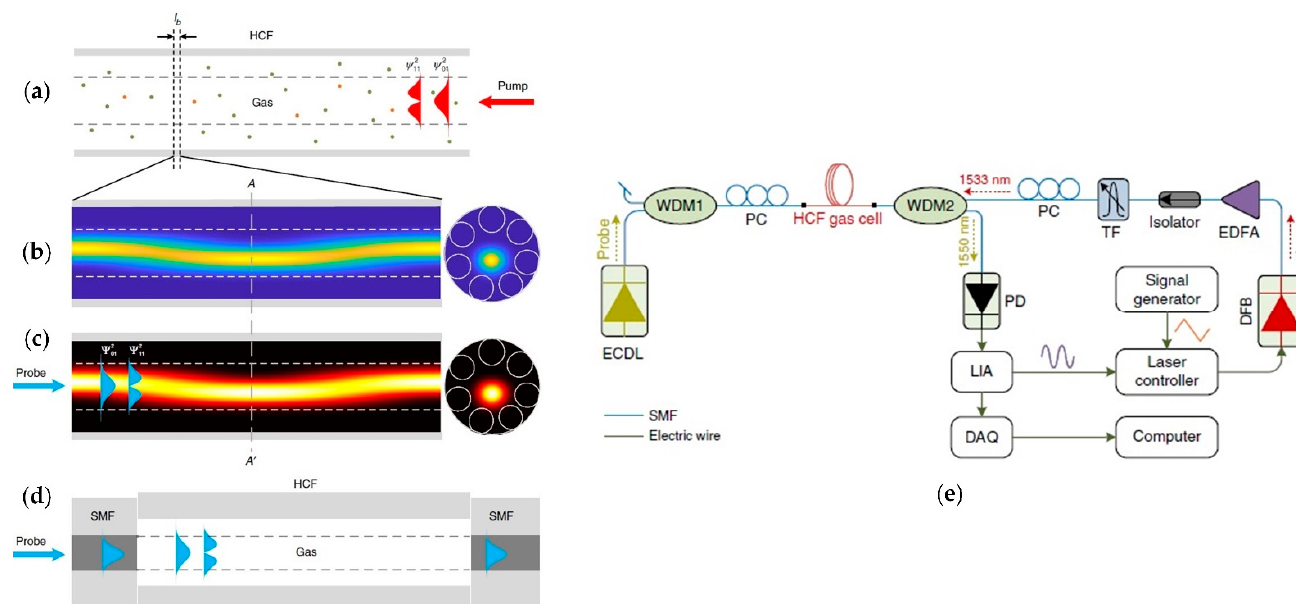
Figure 11. Principle of the MPD-PTS in ARHCF for gas sensing. ( a ) Intensity profiles of the pump LP 01 (cid:4666)𝜓 (cid:2868)(cid:2869)(cid:2870) (cid:4667) and LP 11 (cid:4666)𝜓 (cid:2869)(cid:2869)(cid:2870) (cid:4667) modes in the gas-filled ARHCF. ( b ) Pump intensity change within the modal beat length. ( c ) The temperature change, which induces the RI modulation in the gas-filled ARHCF core while the gas molecules are excited by the pump light. It can be seen that the probe modes LP 01 (cid:4666)Ψ (cid:2868)(cid:2869)(cid:2870) (cid:4667) and LP 11 (cid:4666)Ψ (cid:2869)(cid:2869)(cid:2870) (cid:4667) are experiencing different RI changes. ( d ) A schematic of the in-line dual-mode interferometer. ( e ) Experimental setup of the MPD-PTS sensor utilizing an ARHCF as a C 2 H 2 absorption cell. HCF—hollow-core fiber, SMF—single-mode fiber, I b —modal beat length, WDM—wavelength division multiplexer,